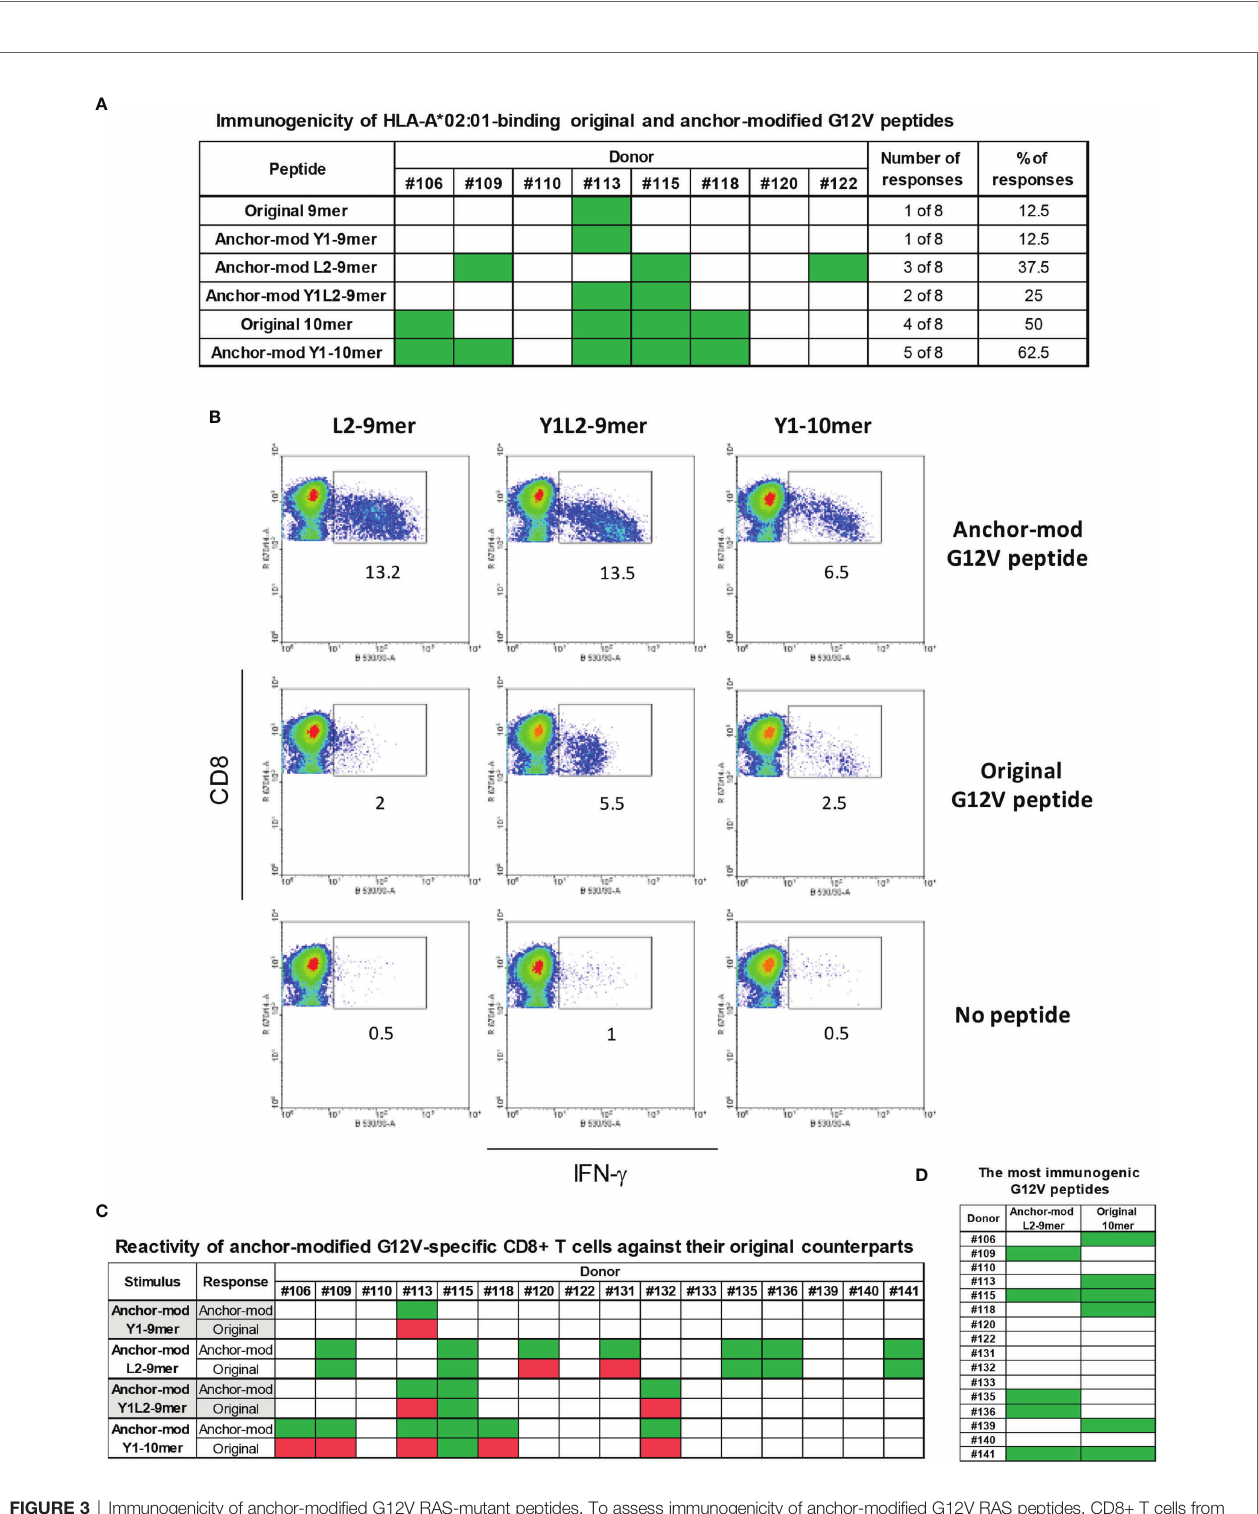
FIGURE 3 | Immunogenicity of anchor-modi fi ed G12V RAS-mutant peptides. To assess immunogenicity of anchor-modi fi ed G12V RAS peptides, CD8+ T cells from healthy donors were stimulated four times with autologous peptide-pulsed mature dendritic cells. Seven days after the last round of stimulation, CD8+ T cells were challenged with T2 cells pulsed with the same RAS mutants (anchor-modi fi ed or original), original or left without peptide. Intracellular IFN- g was measured by FACS. The response from all 8 HLA-A*02:01-positive donors tested so far is shown in (A) . The dot plots in (B) depict the RAS mutations that elicited CD8+ T cell response to three anchor-modi fi ed G12V peptides from a representative donor expressing HLA-A*02:01; and the response from all 16 donors tested (C) ; responses are shown in green - in cases where T cells stimulated against an anchor-modi fi ed peptide did not respond to its original counterpart are marked in red. In (D) is shown all donors who were stimulated with anchor-modi fi ed 9-mer L2 that recognized the original 9-mer and original